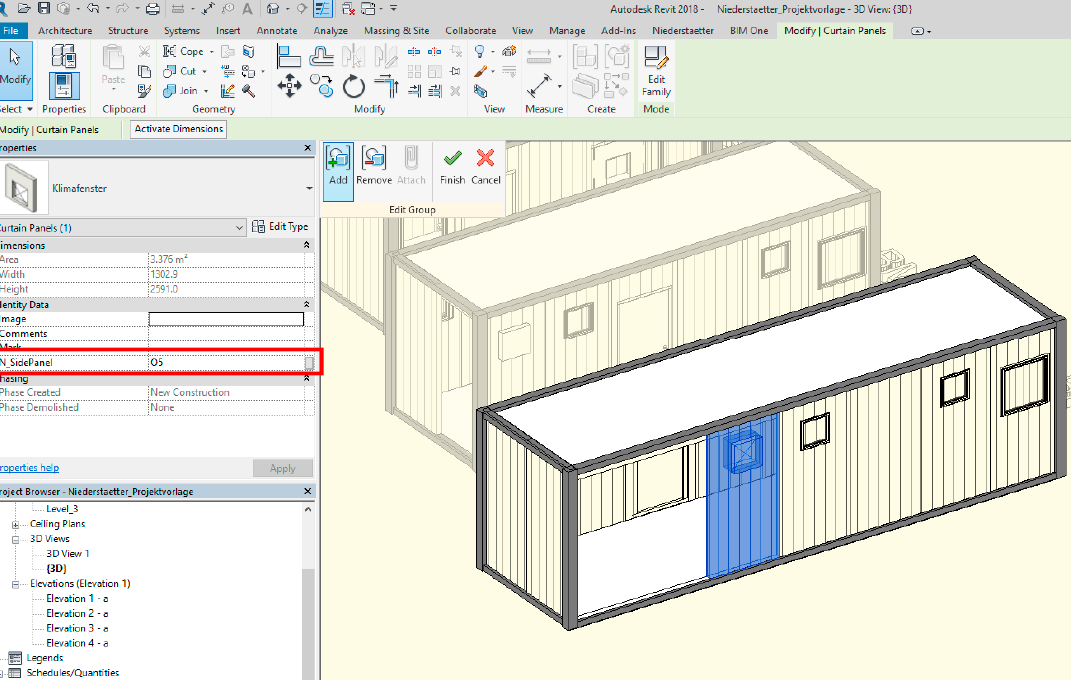
Figure 8. Parameter N_SidePanel in the BIM object